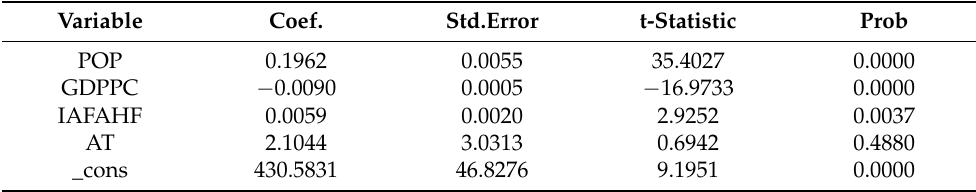
Table 6. Multiple linear regression of